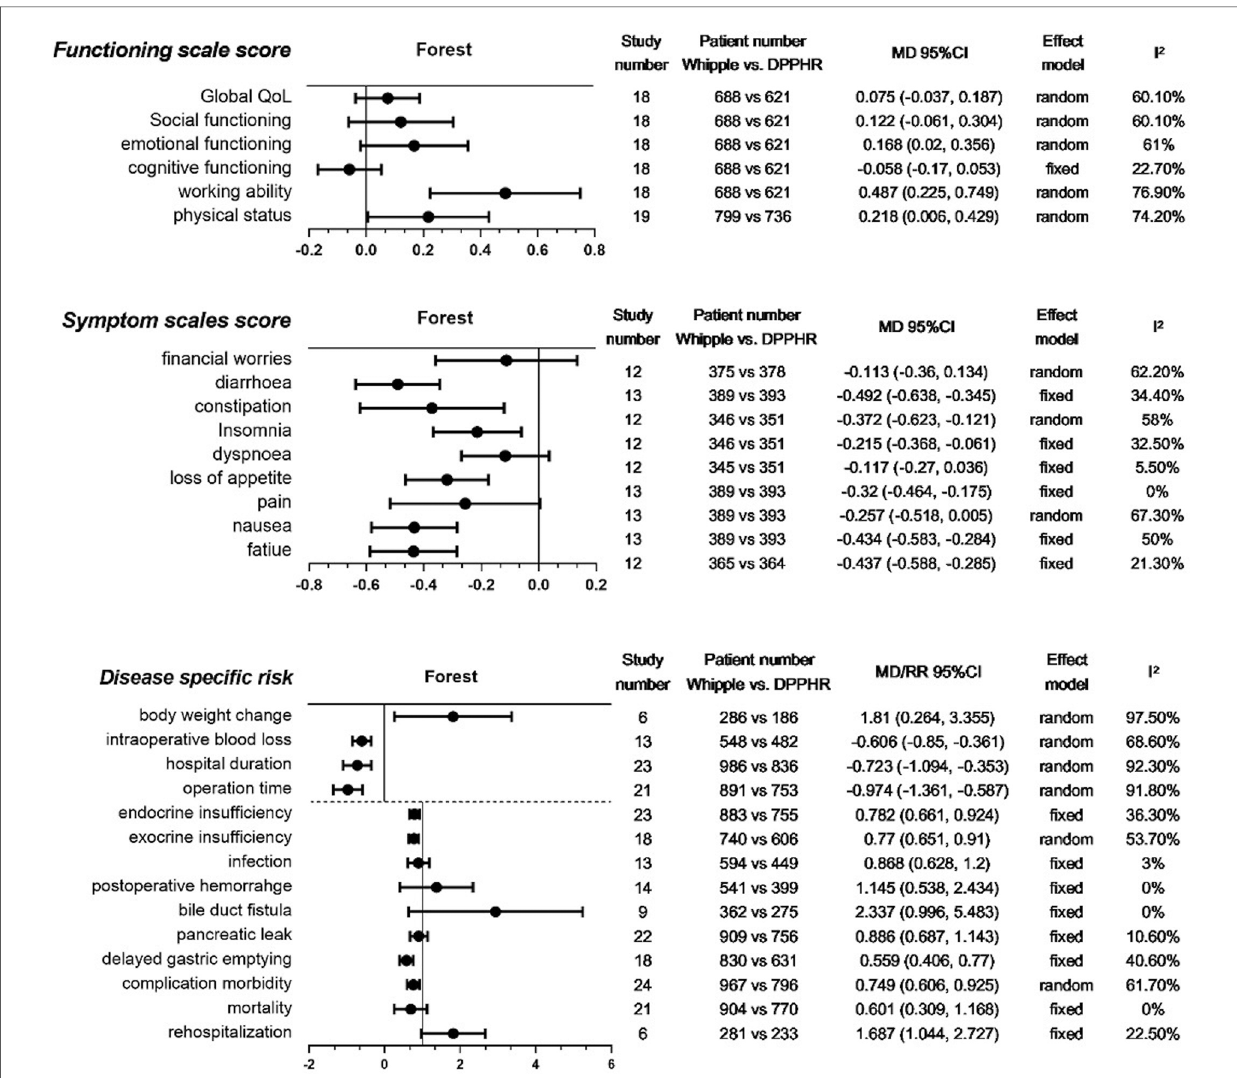
FIGURE 2 Meta-analysis of collected indexes. Meta-analysis of three categories of indexes: functioning scale scores, symptom scale scores, and disease-speci fi c risks. The last 10 indexes of the third category were analyzed by RR. QoL, quality of life; DPPHR, duodenum-preserving pancreatic head resection; MD, mean difference.